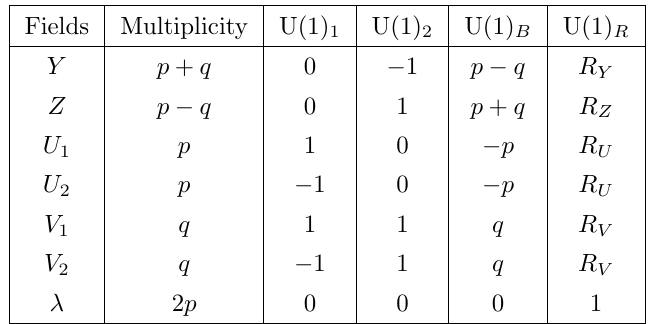
Table 5 . The charges of the various (cid:12)elds in the 4d Y p;q